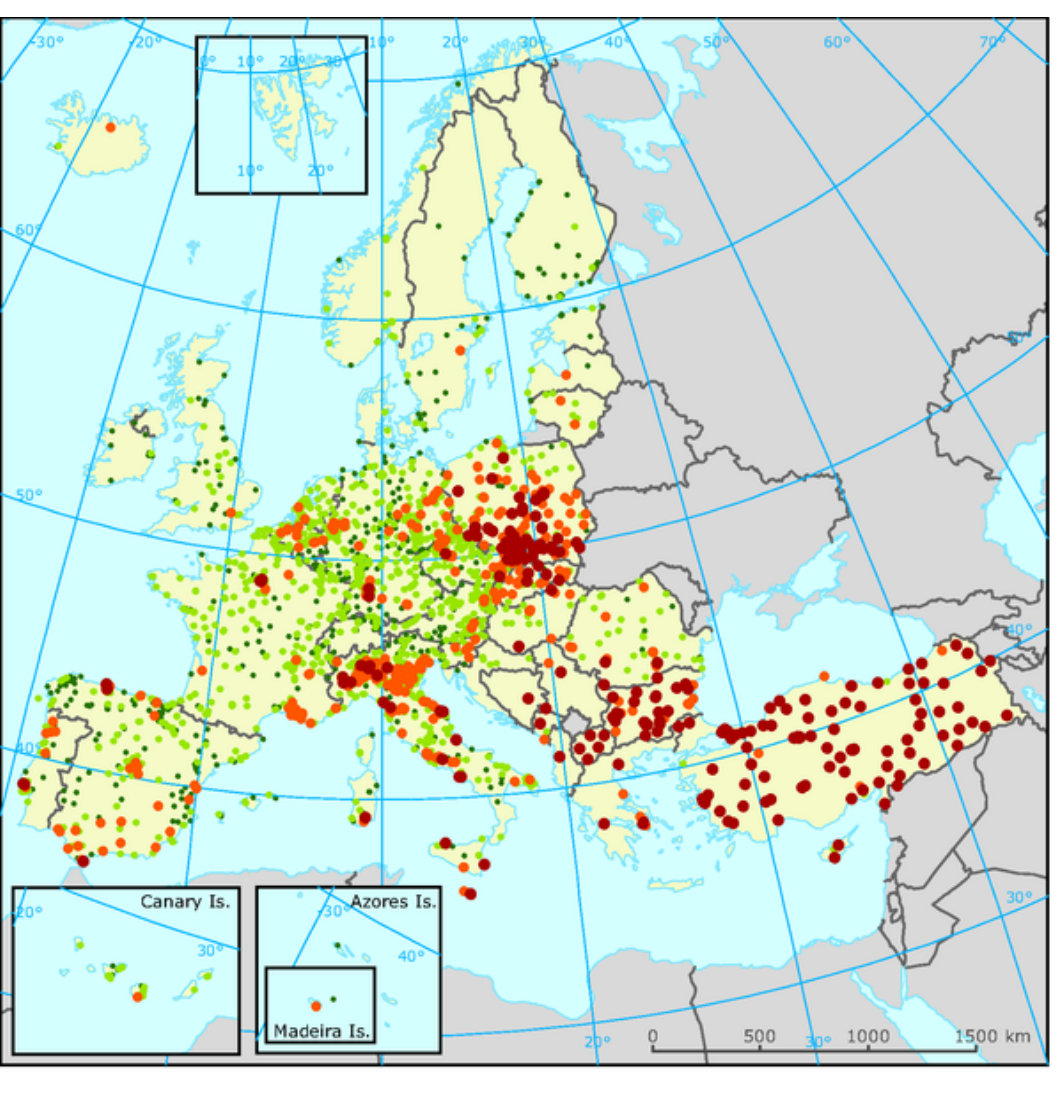
Figure 2. Annual mean PM 10 concentrations in 2010